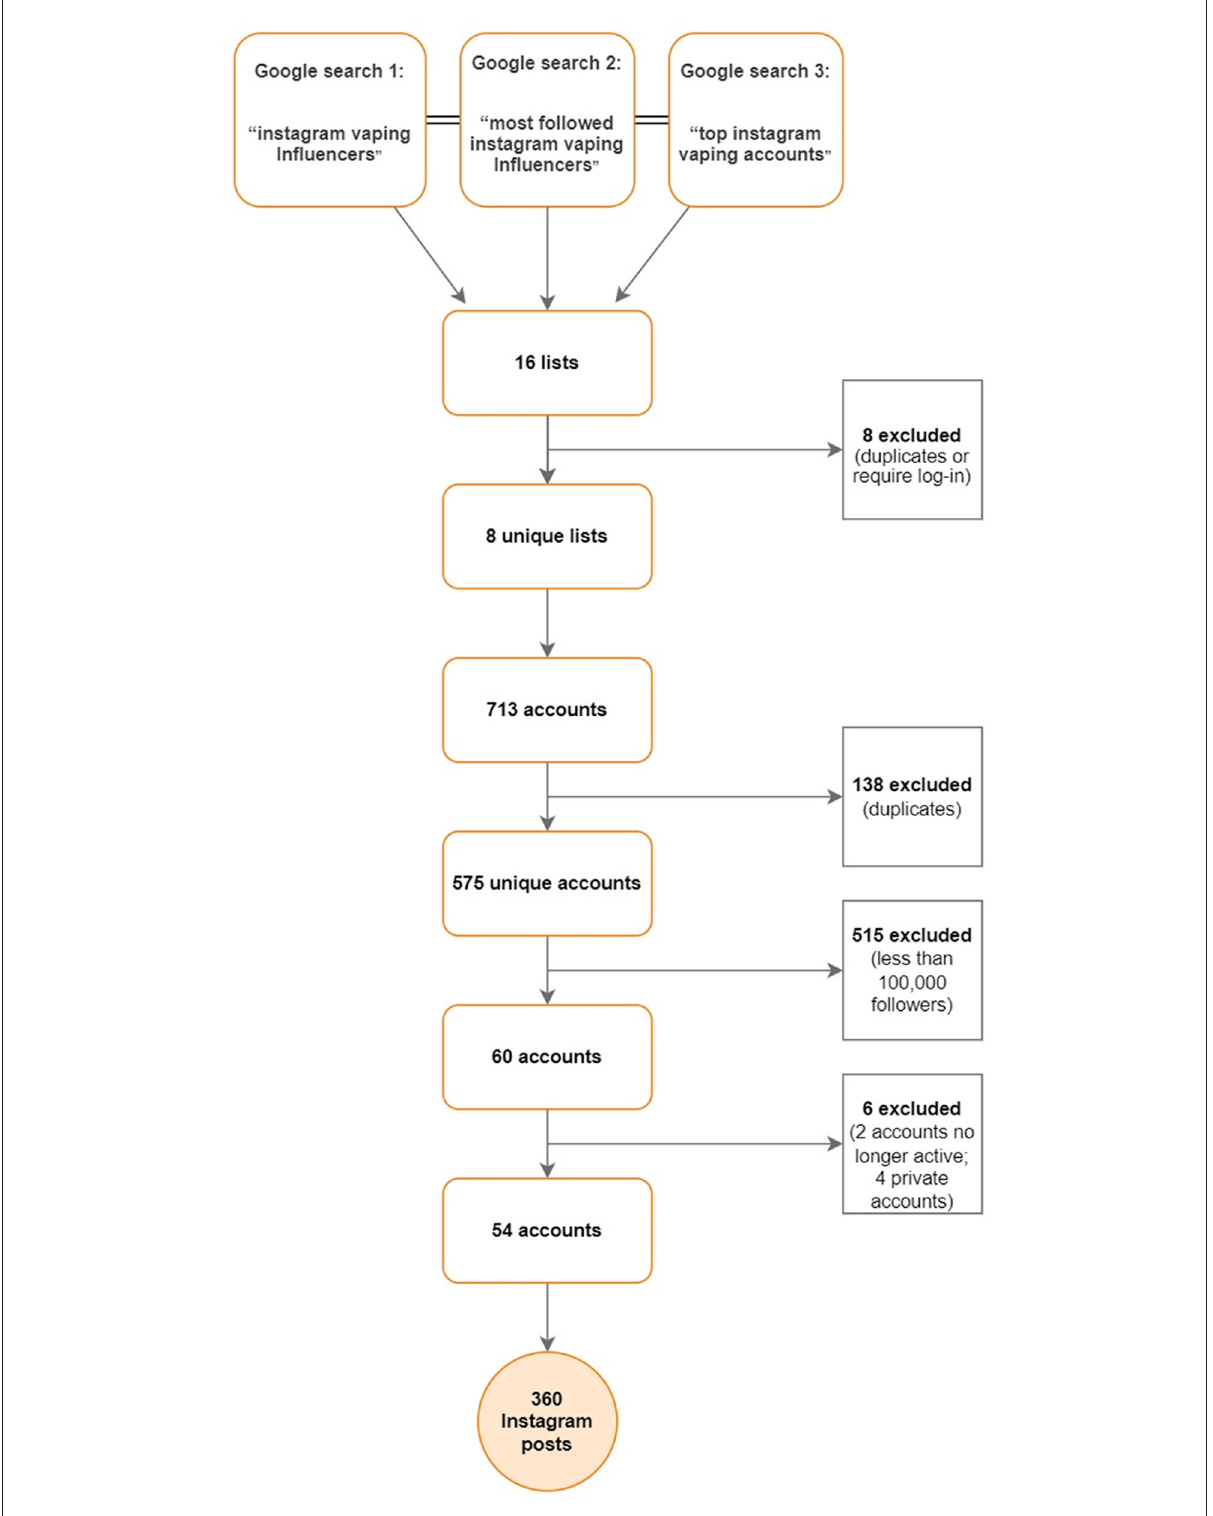
FIGURE1 Flow chart of key search terms, lists, and post